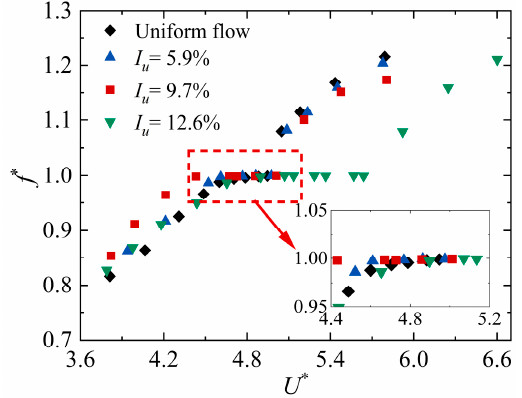
Figure 10. Variation in f * versus U * for different I u .